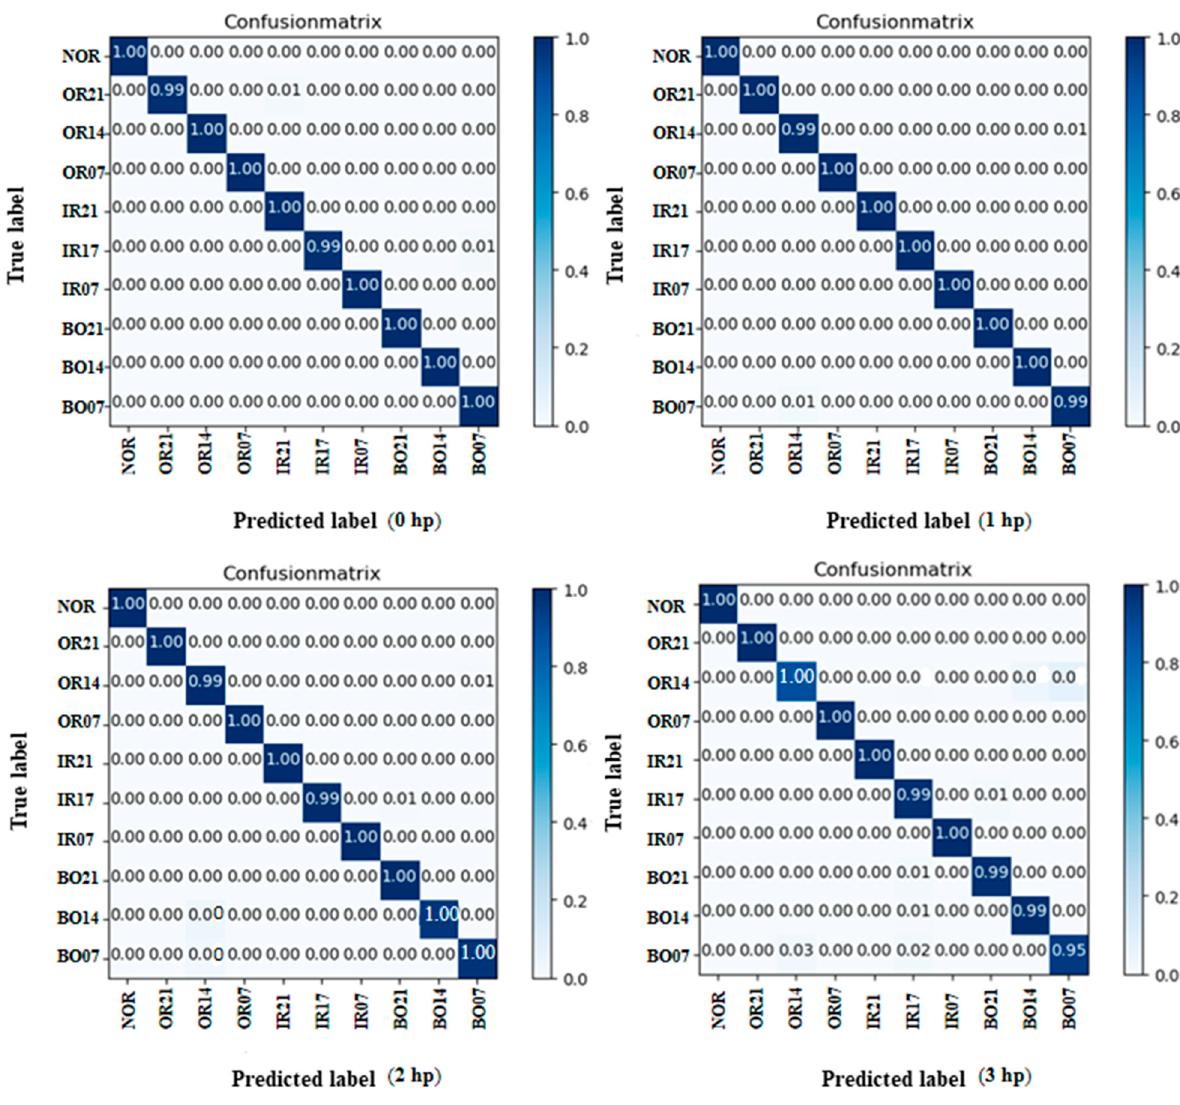
Figure 12. Test results of model under a load of 0.735 N·m/s~2.205 N·m/s.